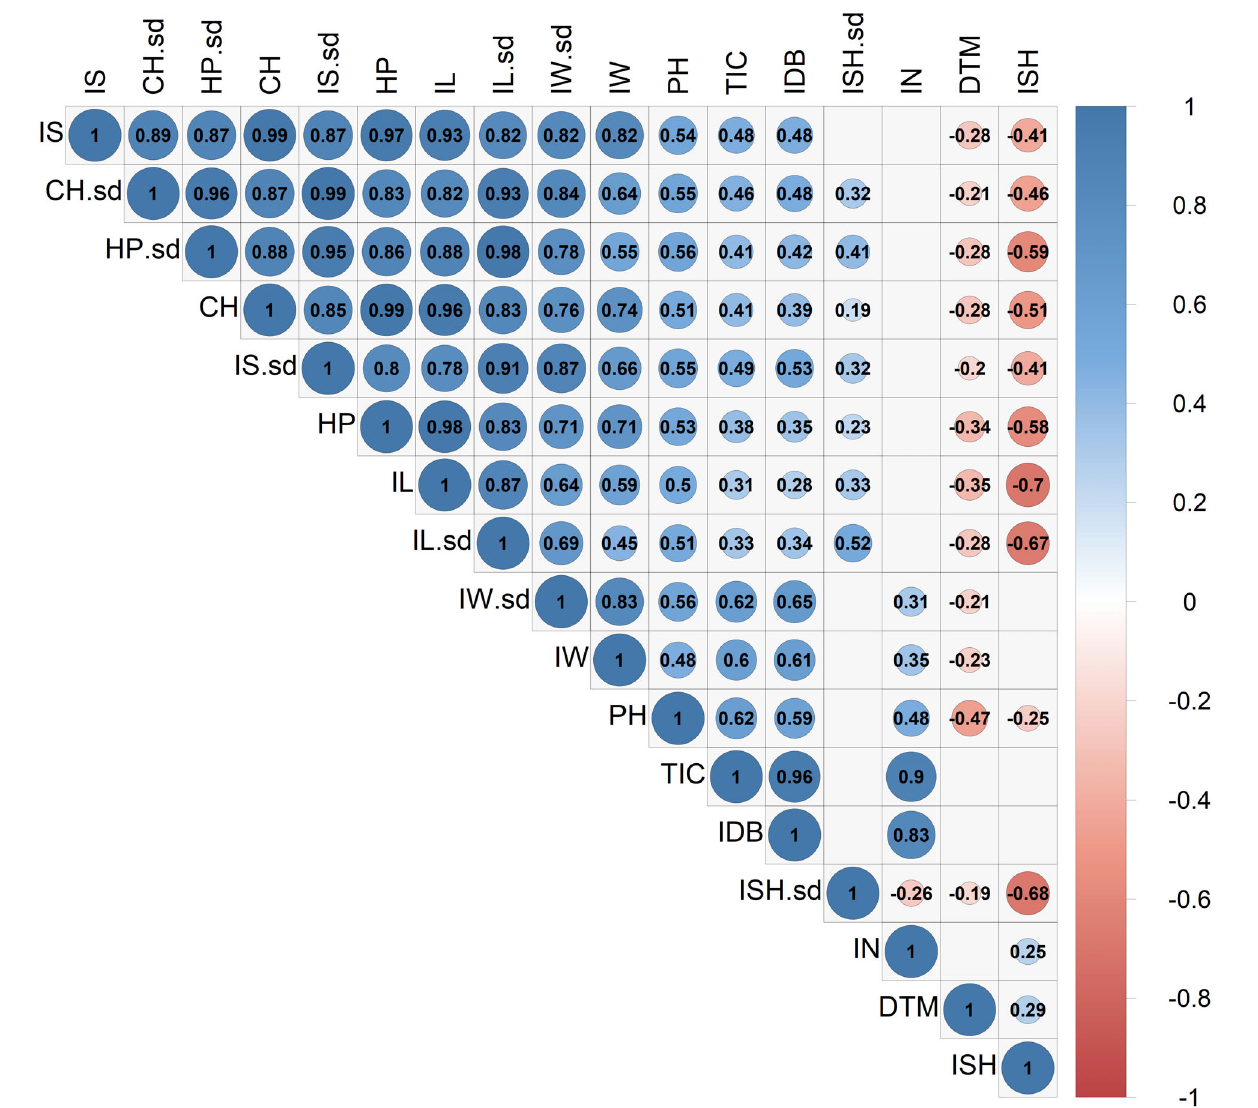
FIGURE 6 | Correlation coefficient matrix for 14 inflorescences’ attributes and 3 physiological parameters. The correlation strength and direction are indicated by colors and numeric (coefficient) values. Blank cells indicate statistically insignificant correlations ( P > 0.05). Abbreviations: Inflorescence Size (IS), Inflorescence Size standard deviation (IS.sd), Convex Hull (CH), Convex Hull standard deviation (CH.sd), Hull Perimeter (HP), Hull Perimeter standard deviation (HP.sd), Inflorescence Length (IL), Inflorescence Length standard deviation (IL.sd), Inflorescence Width (IW), Inflorescence Width standard deviation (IW.sd), Total Inflorescence Coverage (TIC), Inflorescence Number (IN), Inflorescence Shape (ISH), Inflorescence Shape standard deviation (ISH.sd), Inflorescence Dry Biomass (IDB), Plant Height on harvest day (PH), Days To Maturation